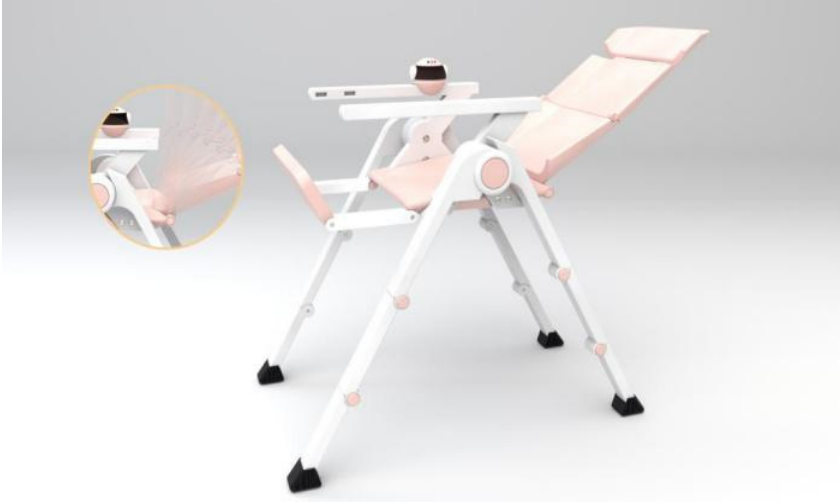
Figure 8. Recliner Mode.